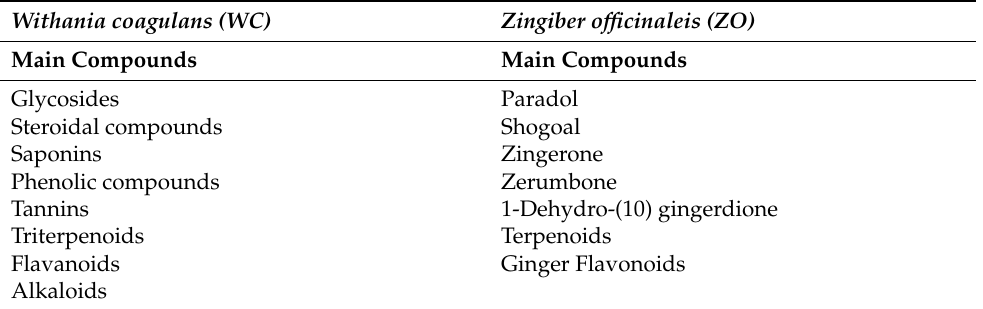
Table 1. Extracts from the experimental plants.